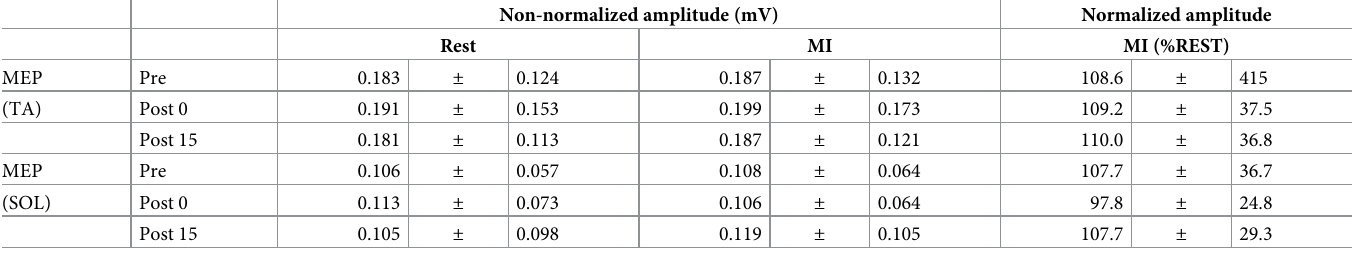
Table 2. Average non-normalized and normalized (% of REST) amplitudes of MEP with SDs in the REST and MI conditions before intervention (Pre), immediately after intervention (Post 0), and 15 min after intervention (Post